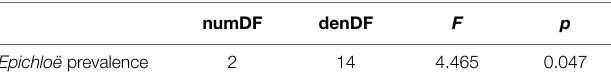
TABLE 5 | Aboveground biomass was correlated with number of leaves at the population level (permutation test of ranged major axis